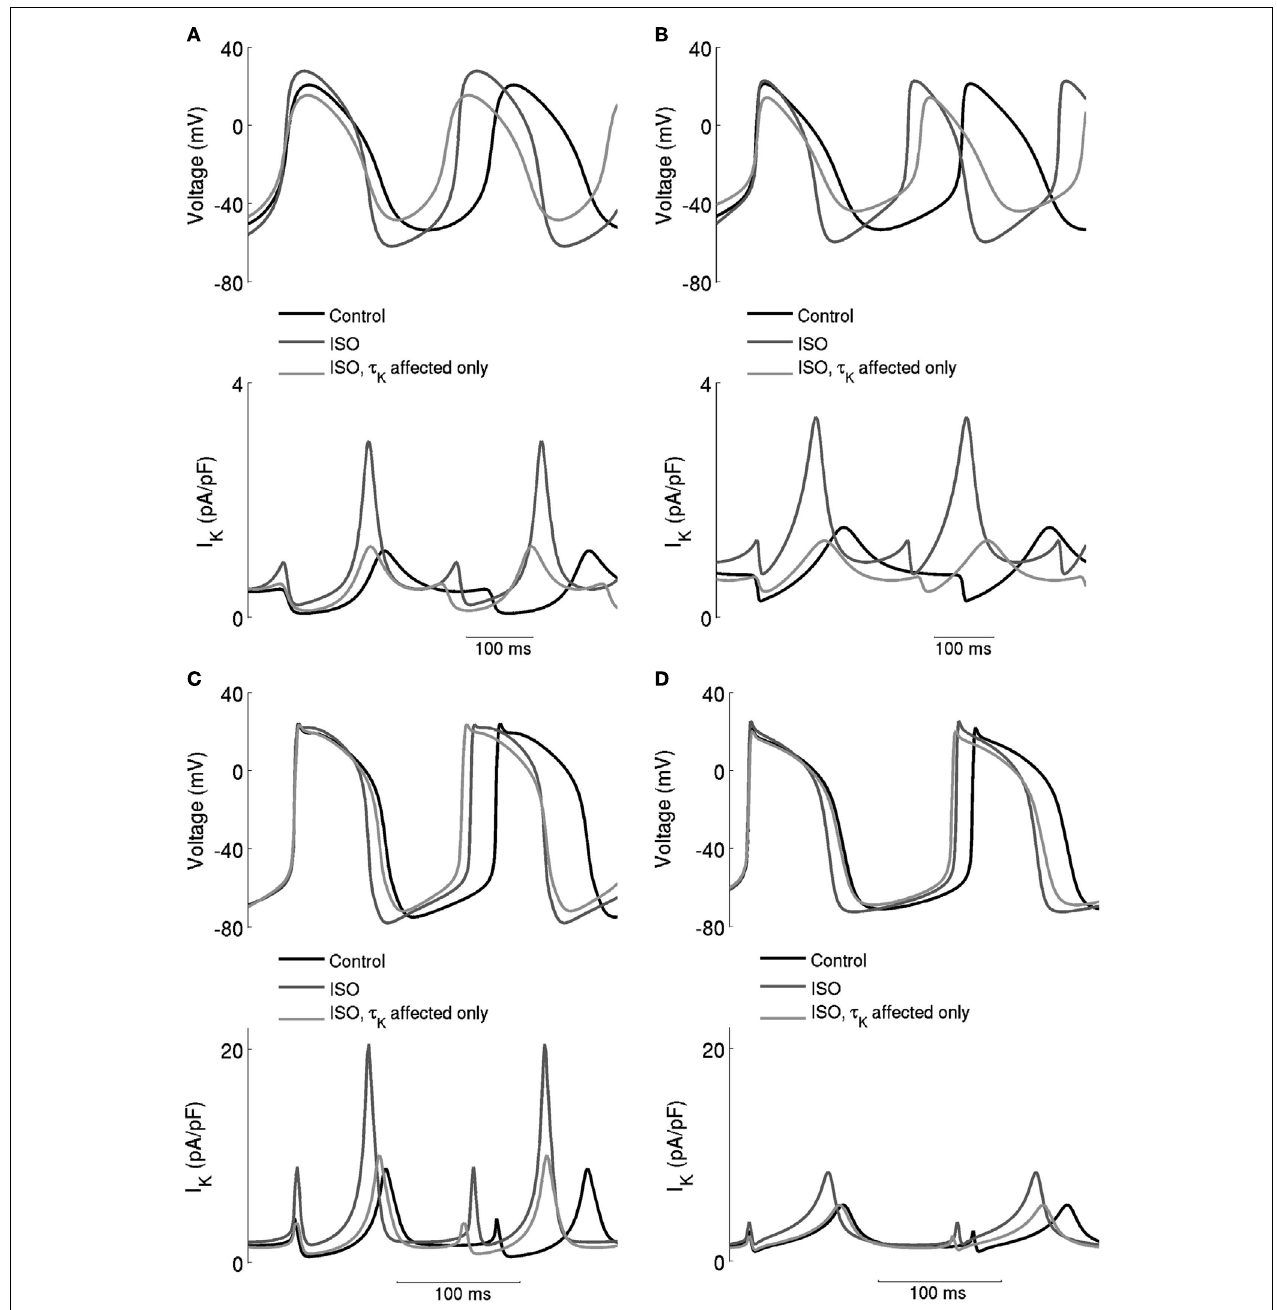
conditions with ISO are shown – in one, only τ Kr was affected and in the other modulatory effects on currents were incorporated.When only τ K was affected, there was a substantial increase of the firing rate, but there was also a large decrease of the maximum diastolic potential, which is not observed